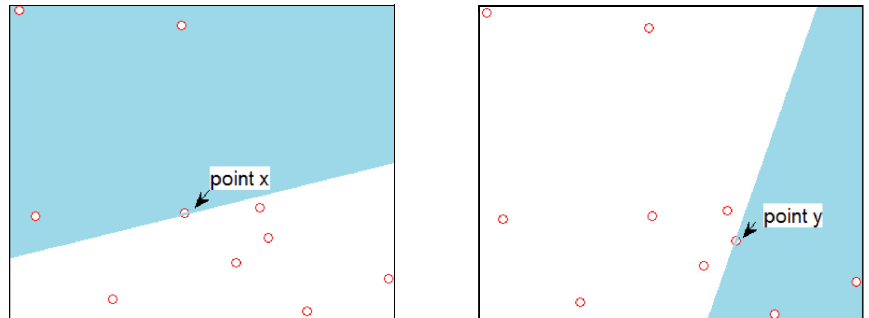
Figure 1. n is equal to ten and the random Tukey depth of x (left-hand side) and y (right-hand side) are, respectively, given, among others, by the randomly obtained closed halfspaces painted in pastel